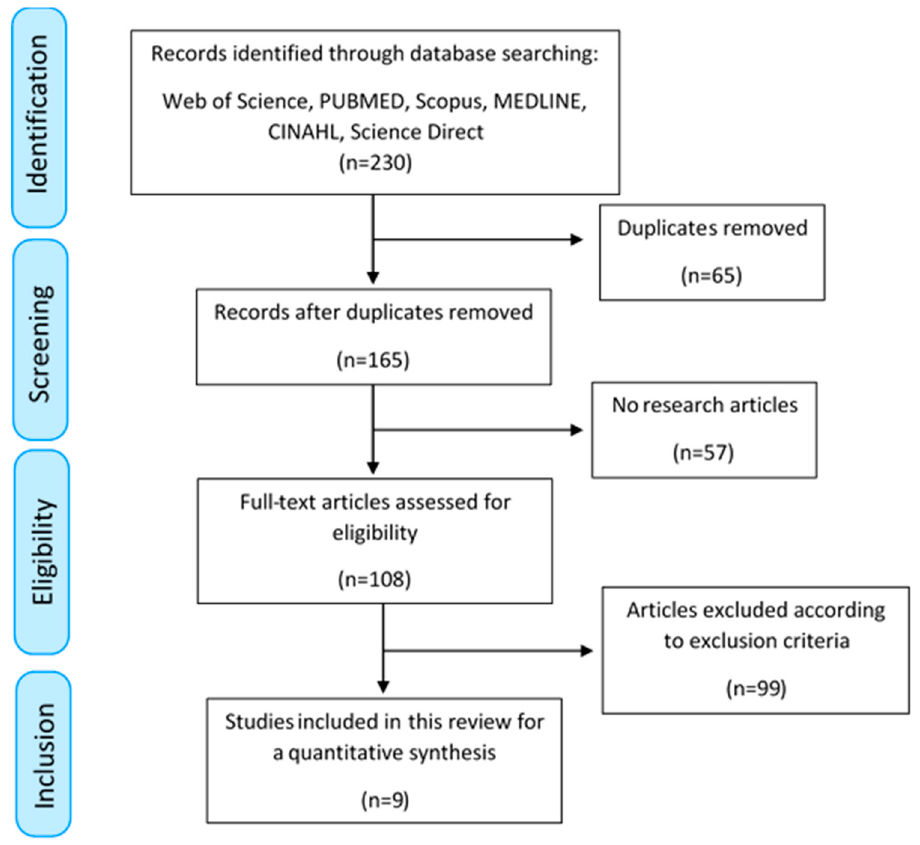
Figure 1. Preferred Reporting Items for Systematic Reviews and Meta-Analyses (PRISMA) diagram of the bibliographic review